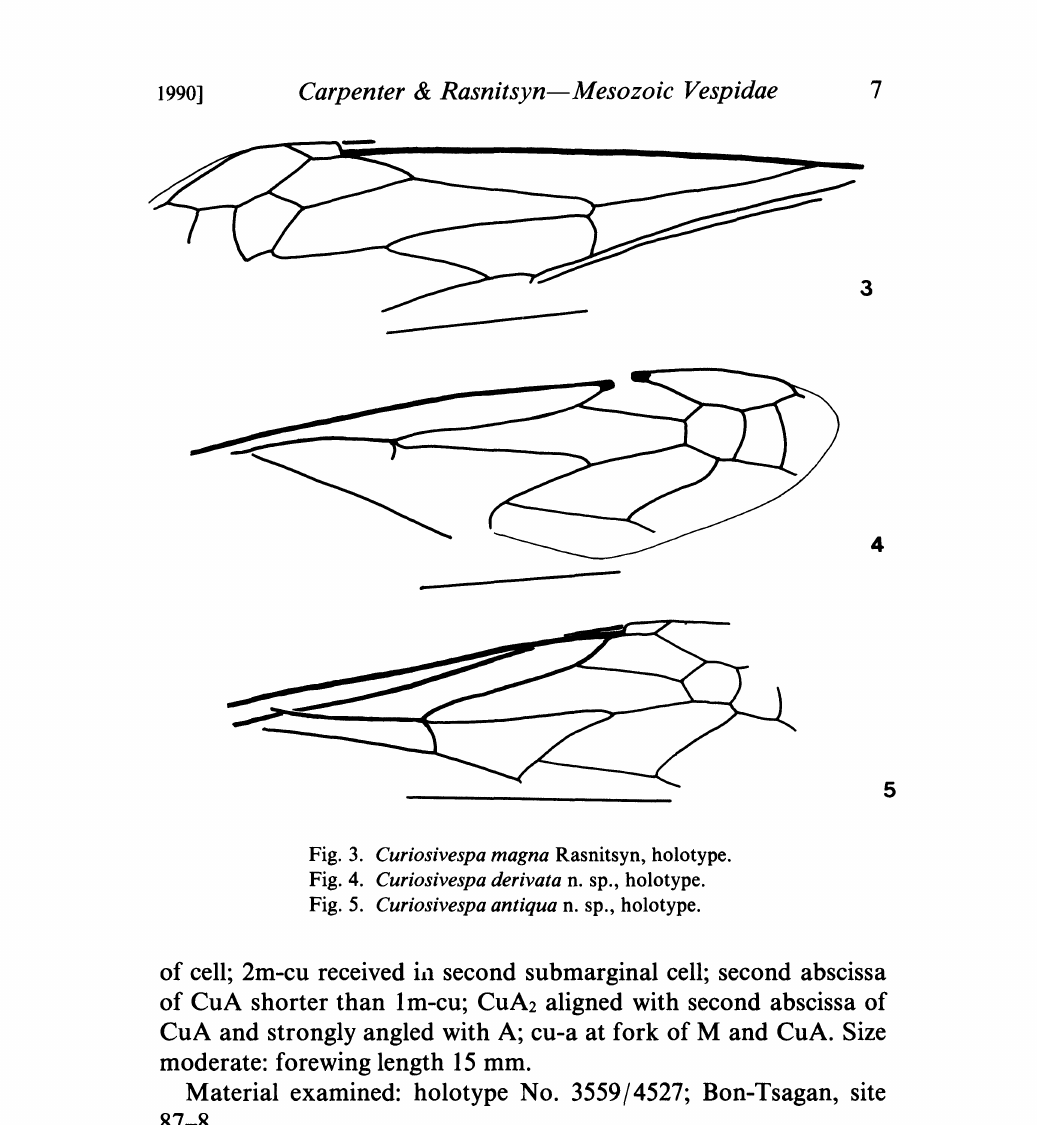
Fig. 3. Curiosivespa magna Rasnitsyn, holotype. Fig. 4. Curiosivespa derivata n. sp., holotype. Fig. 5. Curiosivespa antiqua n. sp.,